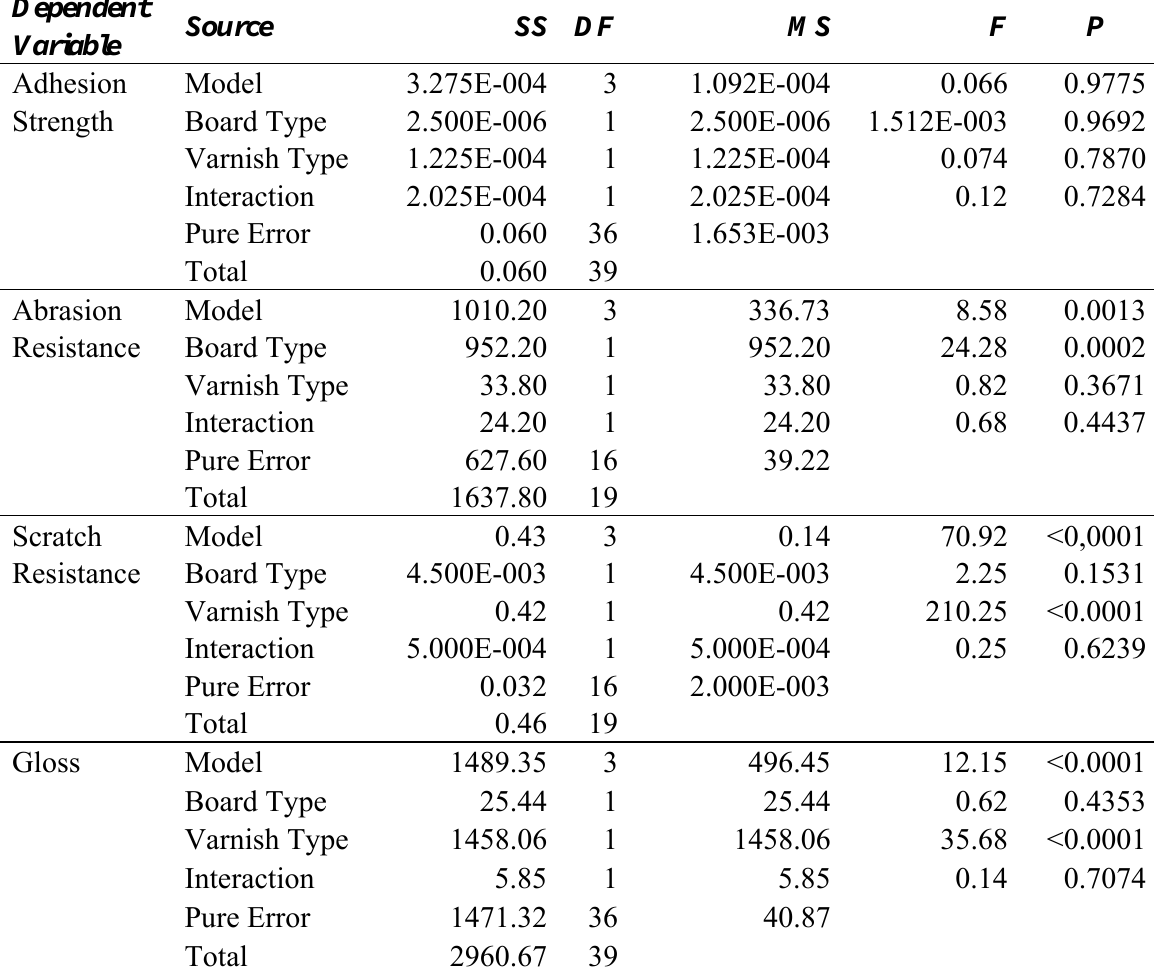
Table 7. Analysis of variance (ANOVA) for adhesion strength, abrasion and scratch resistance, and gloss properties of produced HDPE based wood plastic